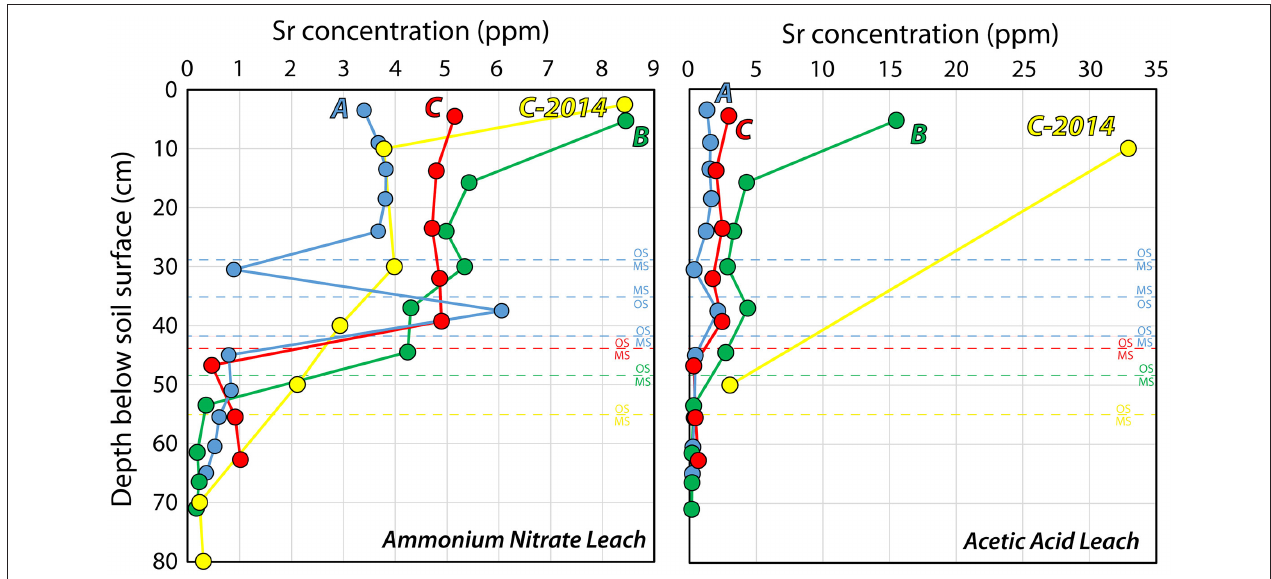
FIGURE 5 | Strontium concentration in the three soil profiles (A, B, C) from the liming test site in ammonium nitrate- and acetic acid leaches. C (2014) shows the concentrations of Sr measured for samples from quadrant C taken in March 2014, about 6 months after the last application of agricultural lime at a rate of 32 t/ha, and 18 months after the first application of agricultural lime at a rate of 16 t/ha, in the course of CO 2 storage experiments (Frei et al., 2020a).